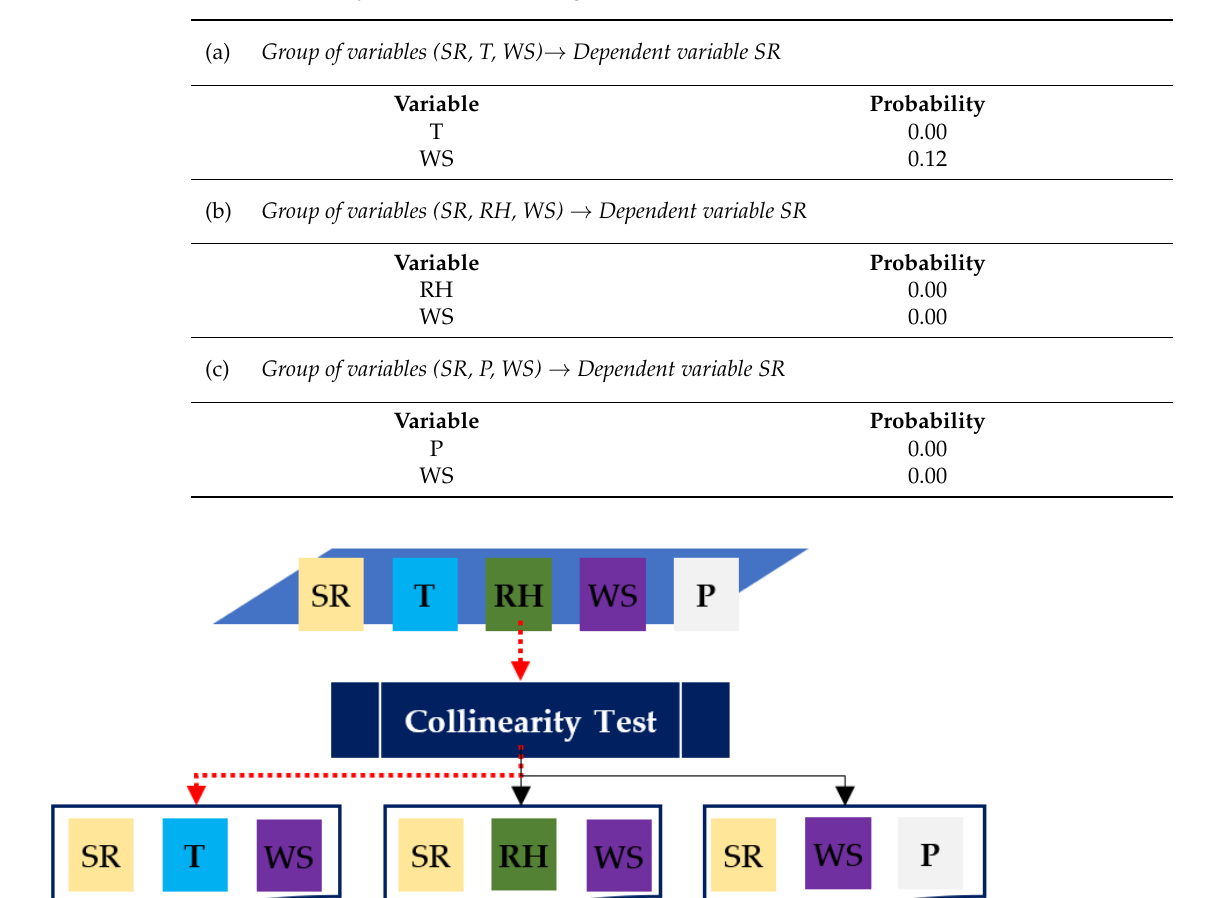
Table 3. Causality test results with a significance level of 1%.